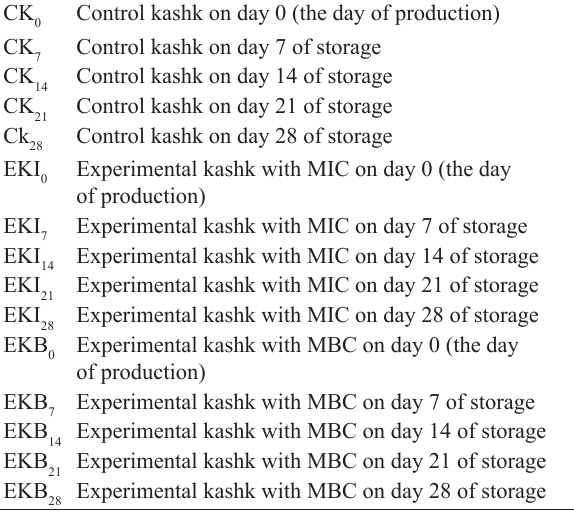
Table 1 Kashk samples under study